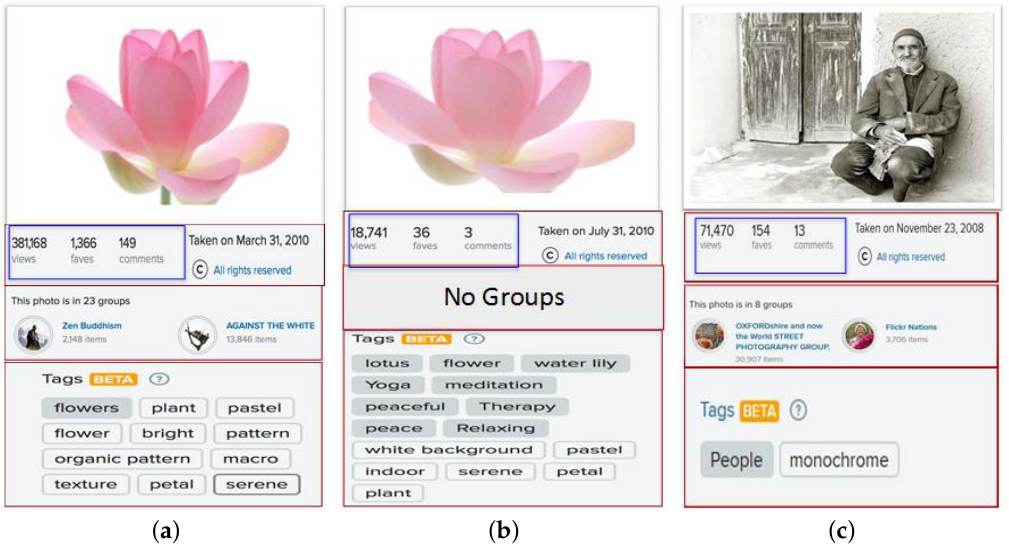
Figure 1. Variation in the number of social interactions between users and images. Visual content, social context, and textual information are important factors for making an image popular. In ( a ), and ( b ) the images share the same visual concept; in ( c ) the image represents different visual